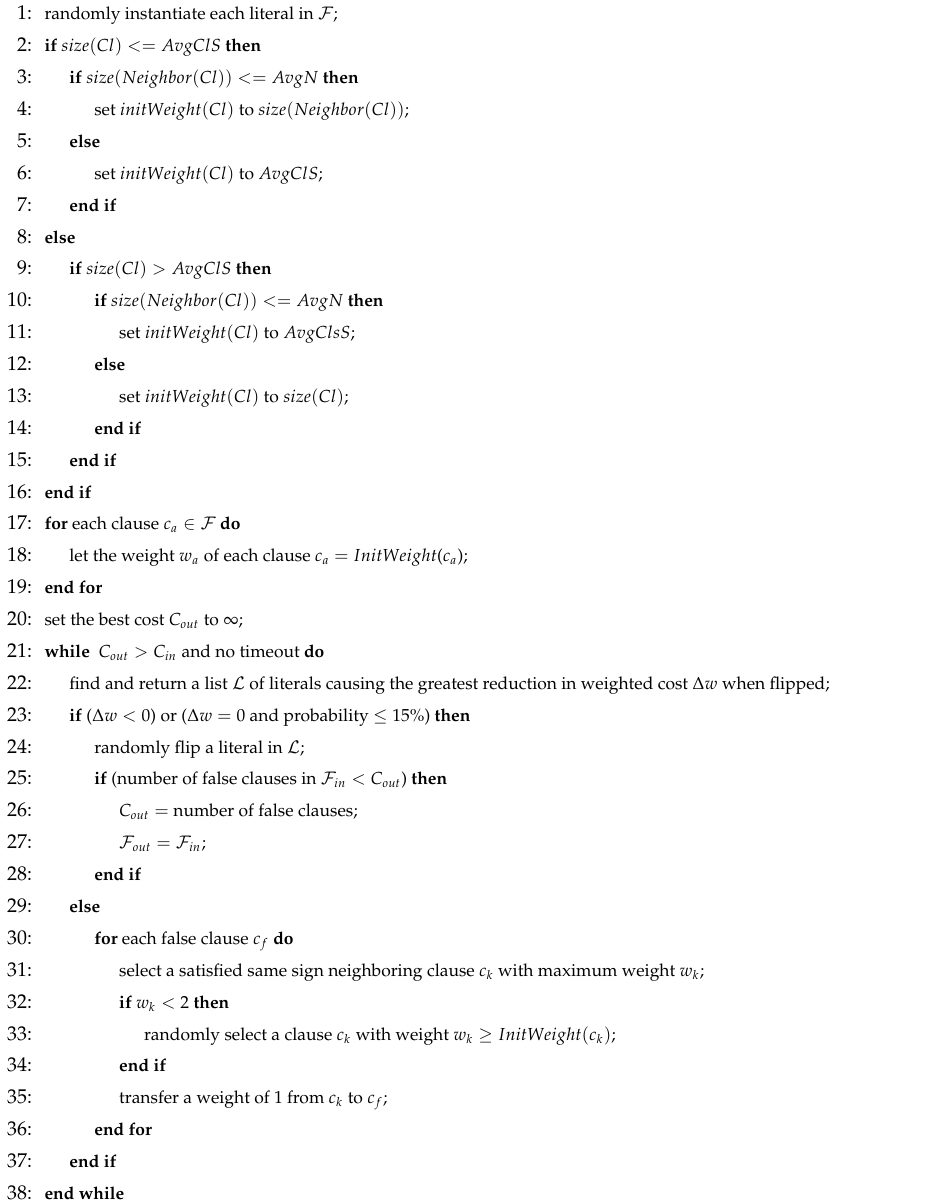
Algorithm 1 DDFW+InitMaxSAT( F in , F out , C in , C out